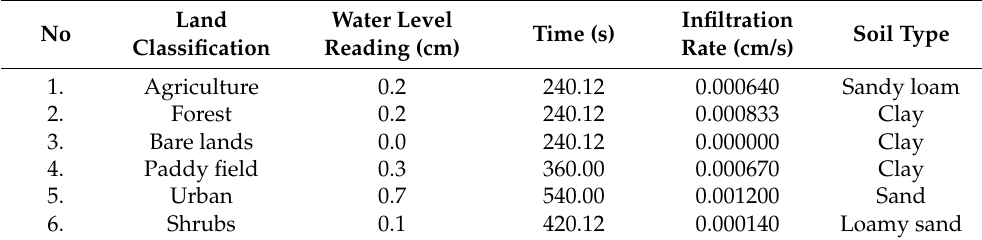
Table 3. Results of infiltration experiments in the